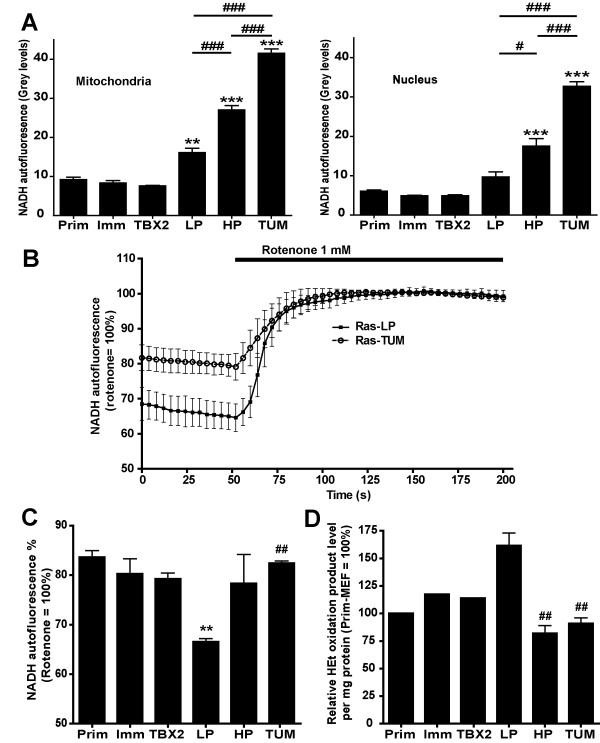
Analysis of NADH autofluorescence. A: Mitochondrial and nuclear NADH autofluorescence levels (mean ± SEM of a minimum of 3 independent experiments) expressed in absolute grey levels. Note that the signals were obtained from cells with clearly distinct morphology, which makes intercomparison of Prim-MEF, Imm-MEF and TBX2-MEF on the one hand, and Ras-transformed populations on the other, difficult. Absolute NADH autofluorescence increases gradually with passage number in H-RasV12/E1A-transformed cells. B: Representative recordings of NADH autofluorescence in Ras-LP and Ras-TUM cells before and after rotenone application. Rotenone inhibition of Complex I results in a differential increase in NADH autofluorescence. The percentage NADH autofluorescence is indicative of different rates of mitochondrial respiration. These data confirm the relatively higher respiration rates in Ras-LP cells. C: Cumulative data from n = 3 NADH autofluorescence/rotenone analyses carried out on separate days, with a minimum of 3 coverslips per day. Note that this parameter is cell morphology-independent. **:p < 0.01 compared to Prim-MEF ##:p < 0.01 for Ras-LP – Ras-TUM intercomparison (one-way ANOVA/Bonferroni). D: Superoxide levels expressed as fluorescence signal of HEt oxidation products per cell. Ras-LP levels were arbitrarily set at 100%. Oxygen consumption data per cell are available in Additional file 1, Fig. S4B and Fig. S4D. HEt fluorescence in Ras-LP, HP and TUM cells was determined in three independent experiments, each in duplicate, with at least 20,000 cells per assay. Prim-MEF, Imm-MEF and TBX2-MEF HEt fluorescence was determined in one experiment, in duplicate. Superoxide levels correlate with respiration rates measured in (B) and (C). ##:p < 0.01 compared to Ras-LP in a Student's t-test.